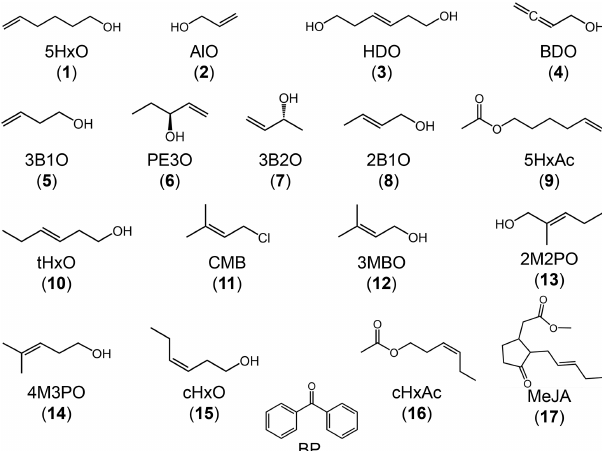
Figure 1. Chemical structures of the reactant species used in this study: 17 alkenes and one model triplet, benzophenone. Compound numbers are in